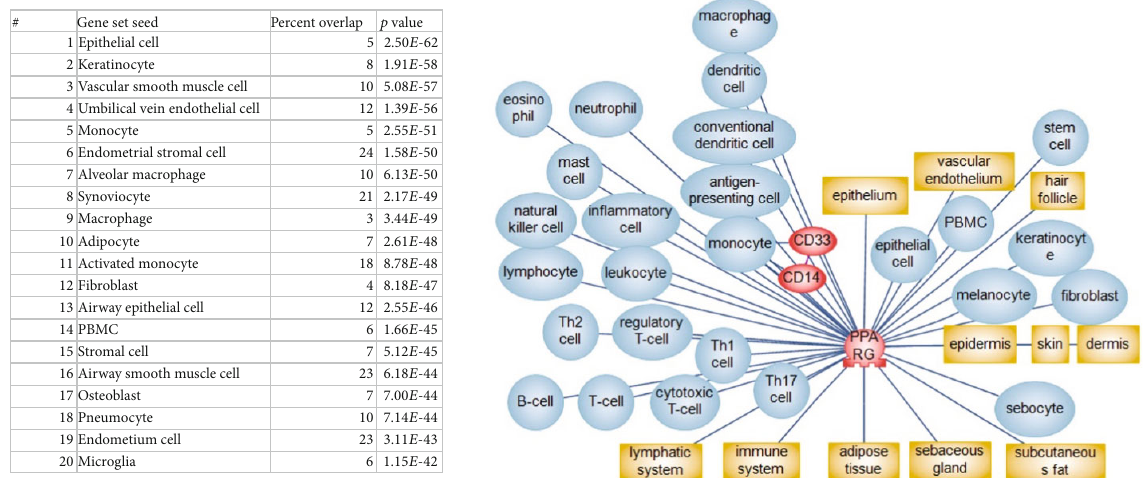
Figure 5: Cells associated with downregulated PPAR γ signaling. SNEA method and Pathway Studio were used to calculate the results. See the complete list with statistics in supplemental materials, “ PPARG and cell ” fi